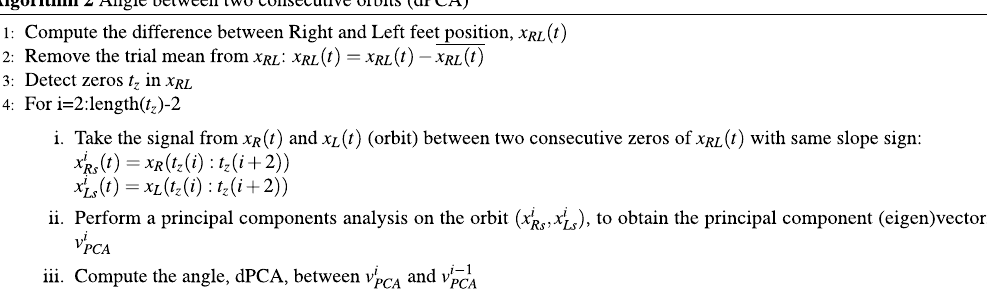
Statistical analysis. Separate two-way repeated-measures analysis of variance (ANOVA) were conducted for MSJR and dPCA, with Speed (five speeds) and Ankle Impedance (with or without imposed ankle stiffness) as within-subjects factors. The interaction between speed and ankle impedance was examined. Additionally, separate one-way repeated-measures ANOVA were conducted for MSJR and dPCA, with Different Experiments (Level, Tilt, Slope Ascending, Slope Descending, Ankle Impedance) at 1.4 mph (2.25 km/h) as a within-subjects factor. The Greenhouse–Geisser correction factor was applied to the within subjects effects and a Bonferroni adjustment was applied to compensate for multiple comparisons. Significance was set at α = 0.05 for all sta- tistical tests. The median of the dependent variables (MSJR and dPCA) over strides was used in the statistical